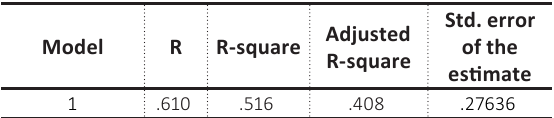
Table 4. Model summary